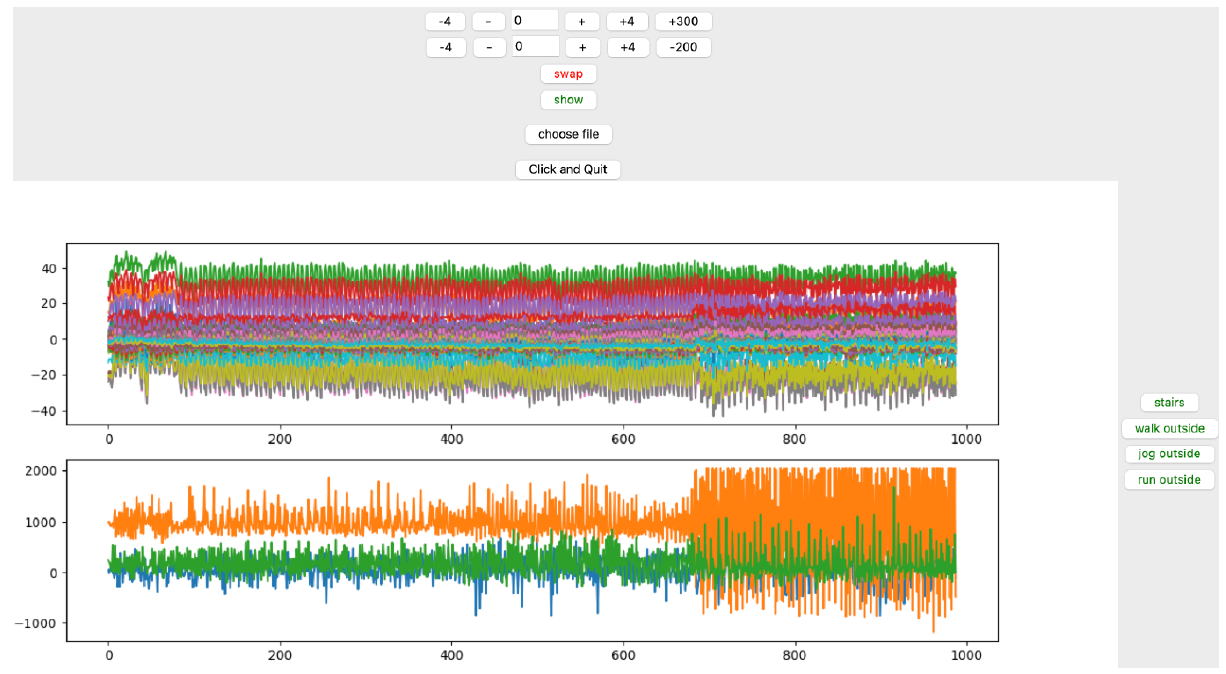
Figure 6. The GUI for outdoor activities. The initial experiment included four outdoor activities, which was reduced to three by combining walking and jogging in the later steps during data